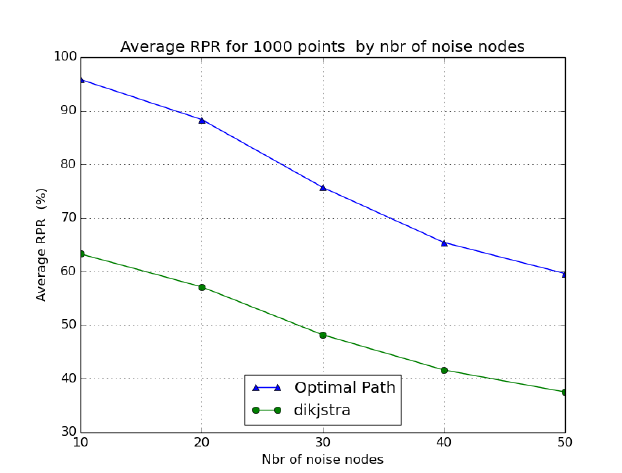
Figure 12. Path lengths with different number of noise nodes, h=60m